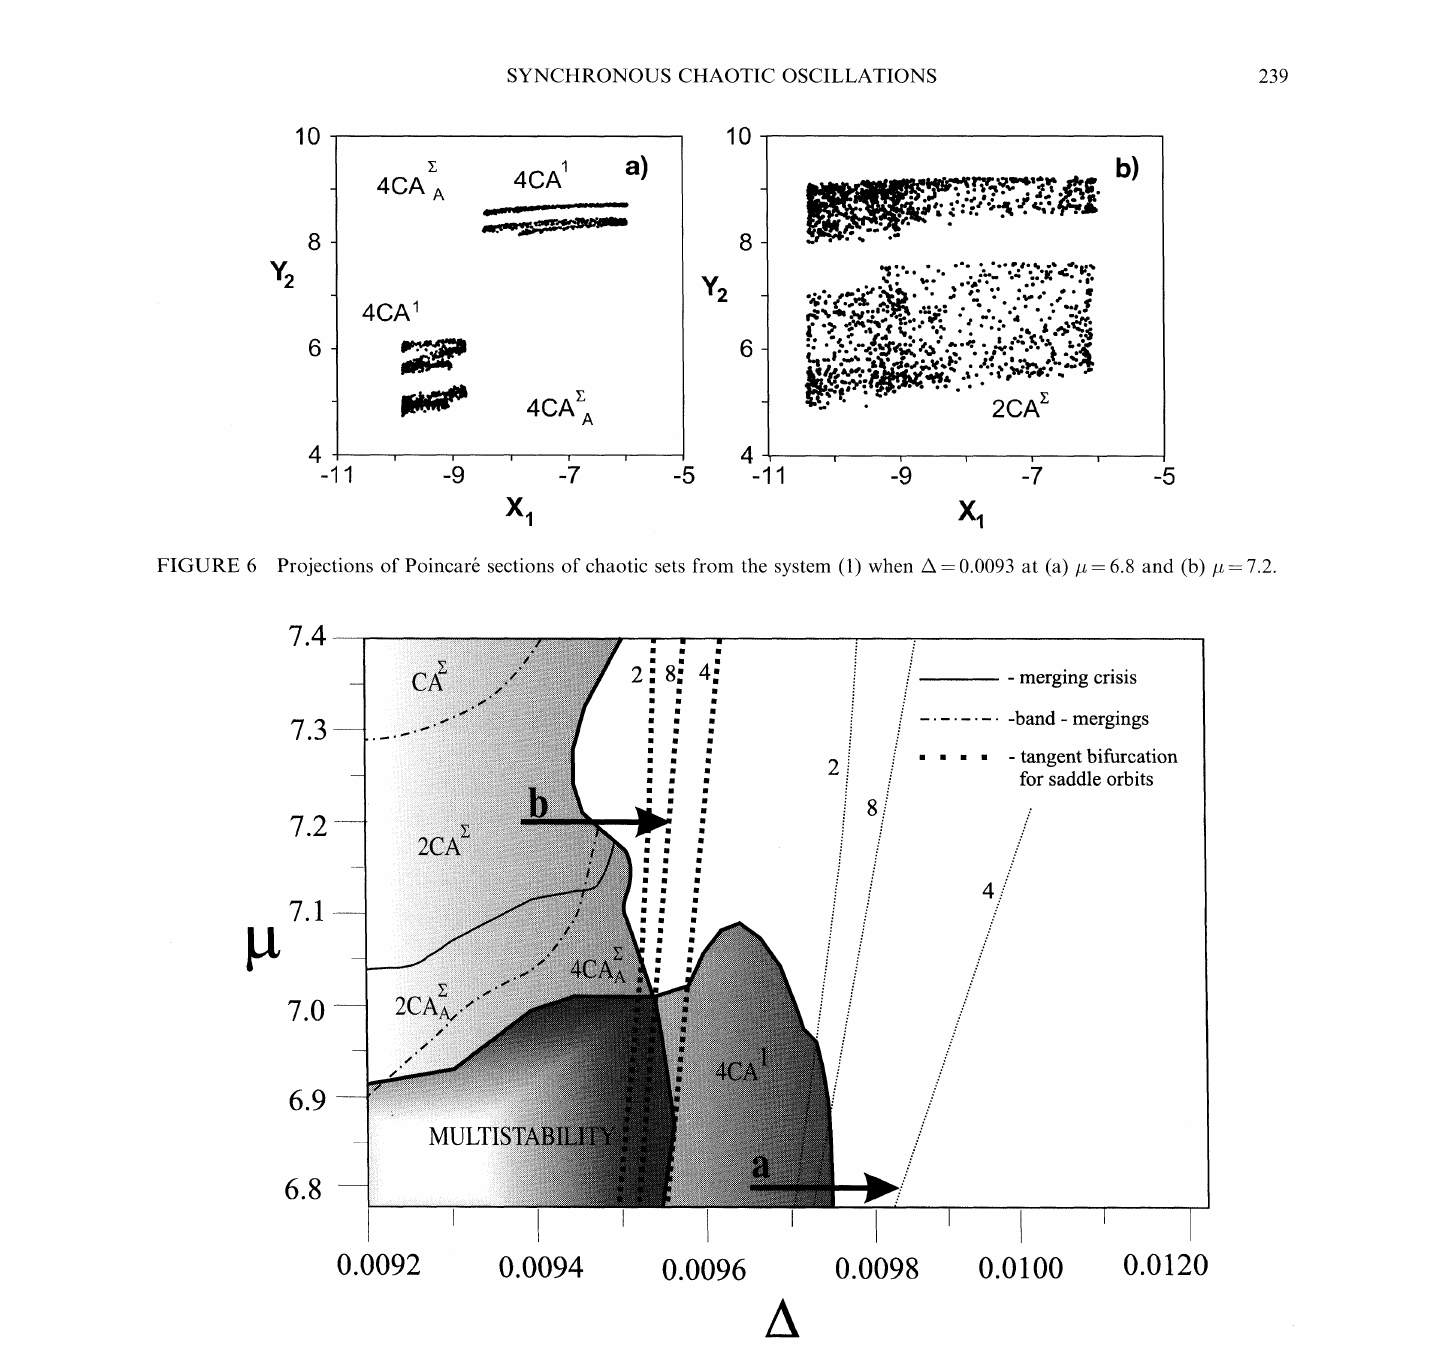
FIGURE 7 Bifurcational diagram near the boundary of the synchronization region. Dotted curves of different width corre- spond to the attractors of the branches A and B. Numbers 2, 4, and 8 denote the periods of saddle